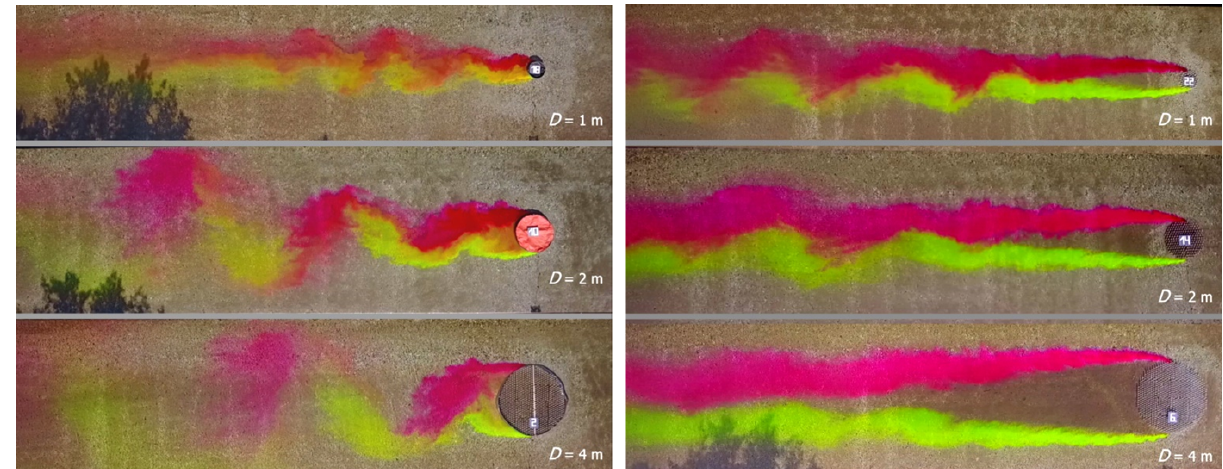
Figure 6. Examples of flow visualizations (a) in runs with an emerged solid obstruction and (b) in runs with an emerged porous obstruction (labels on the objects show the run number; see Table